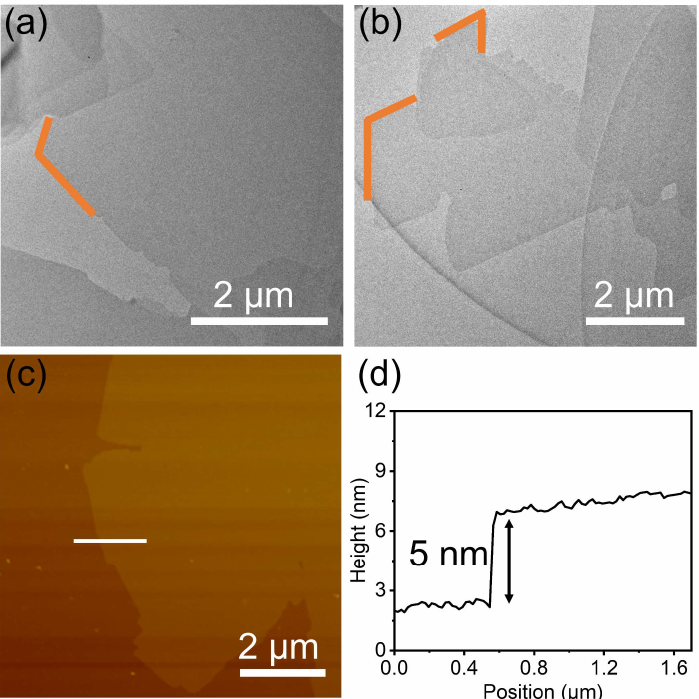
Figure 2. ( a ) and ( b ) are TEM images of P1 . Orange segments mark angles. ( c ) AFM image of P1 on SiO 2 /Si. The white line marks the position of the cross-section. ( d ) Cross-sectional analysis along the white line in c .